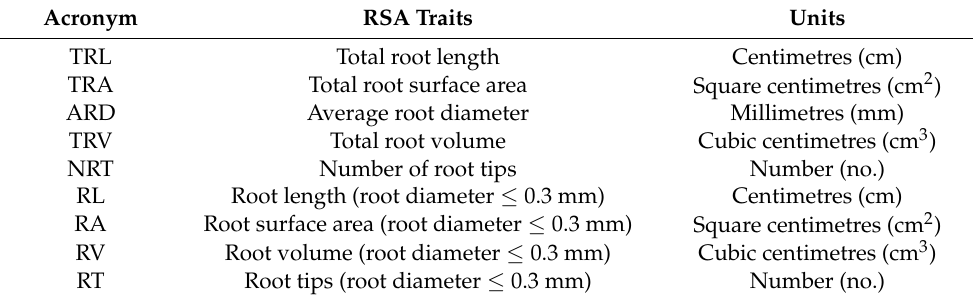
Table 6. Abbreviations for RSA traits and their